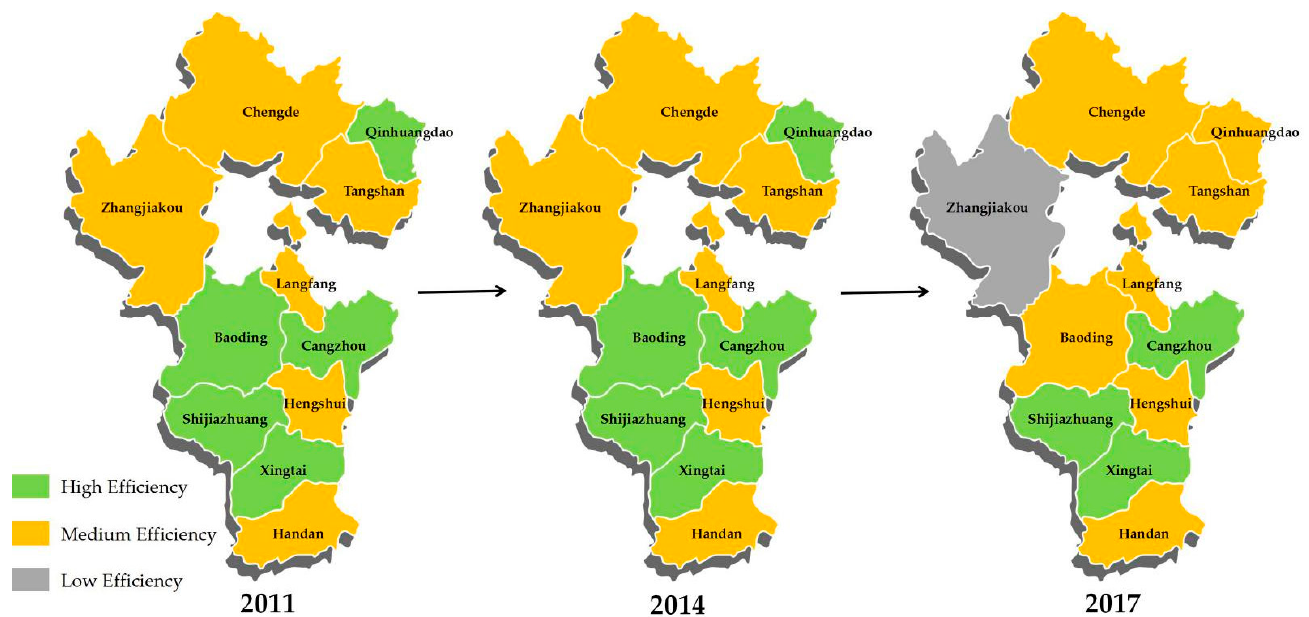
Figure 8. Spatio-temporal evolution map of land economic efficiency in Hebei Province.